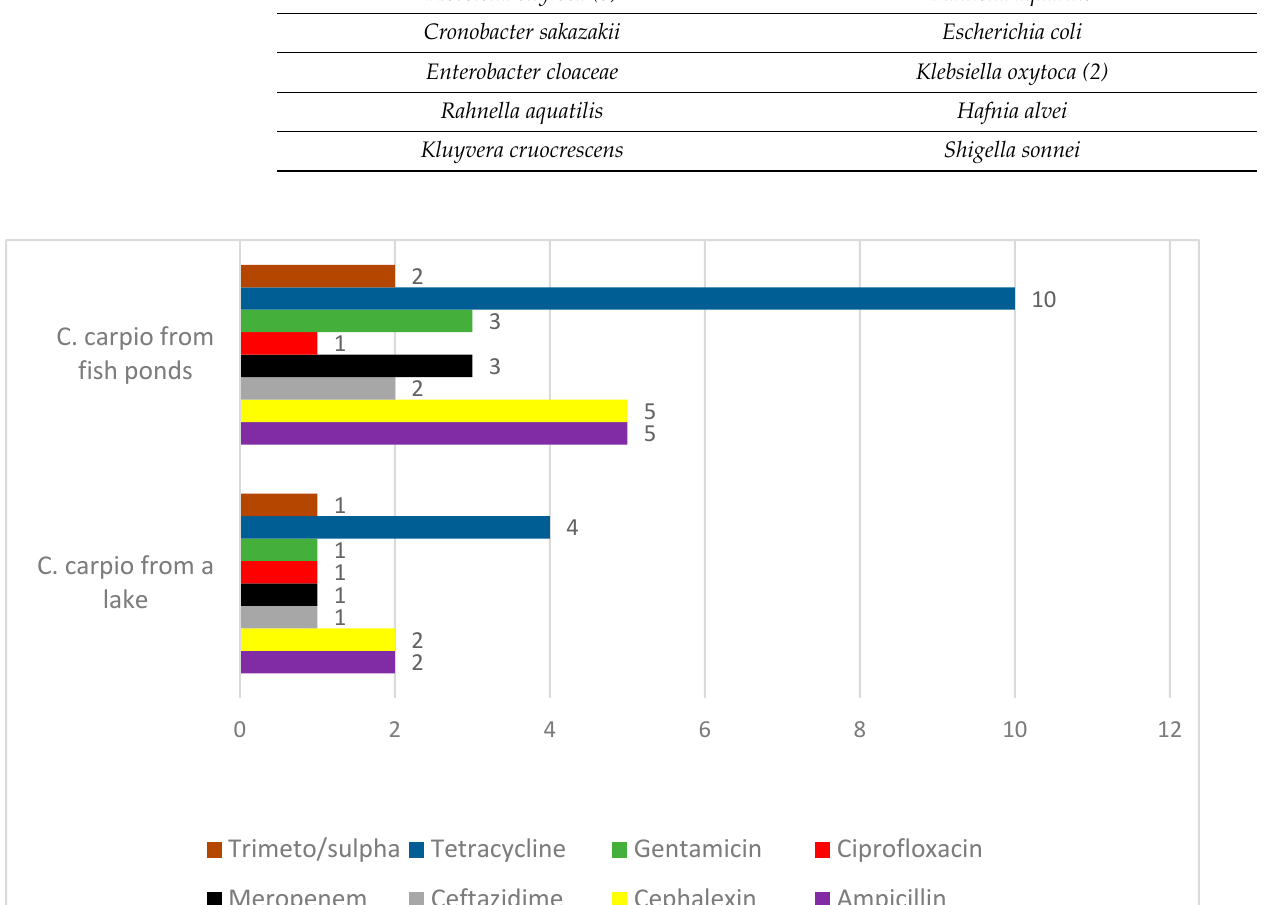
Bacteria of the family Enterobacteriaceae showed a wide spectrum of resistance to